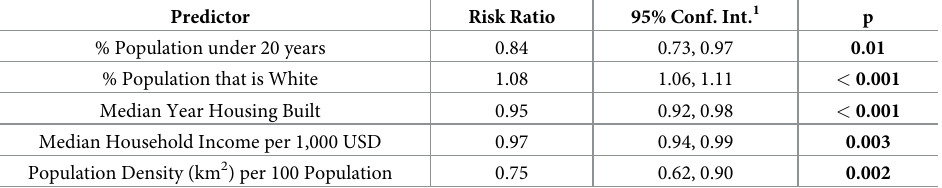
Table 4. Results of univariable analyses for potential predictors of county-level LACV-ND risk in Ohio, West Vir- ginia, North Carolina, and Tennessee from 2003–2021.